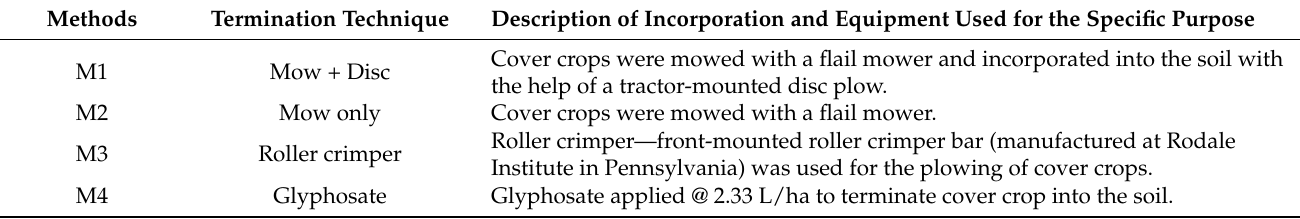
Table 3. Methods of termination of cover crops and incorporation into the soil for experimental treatments for Experiment 2.